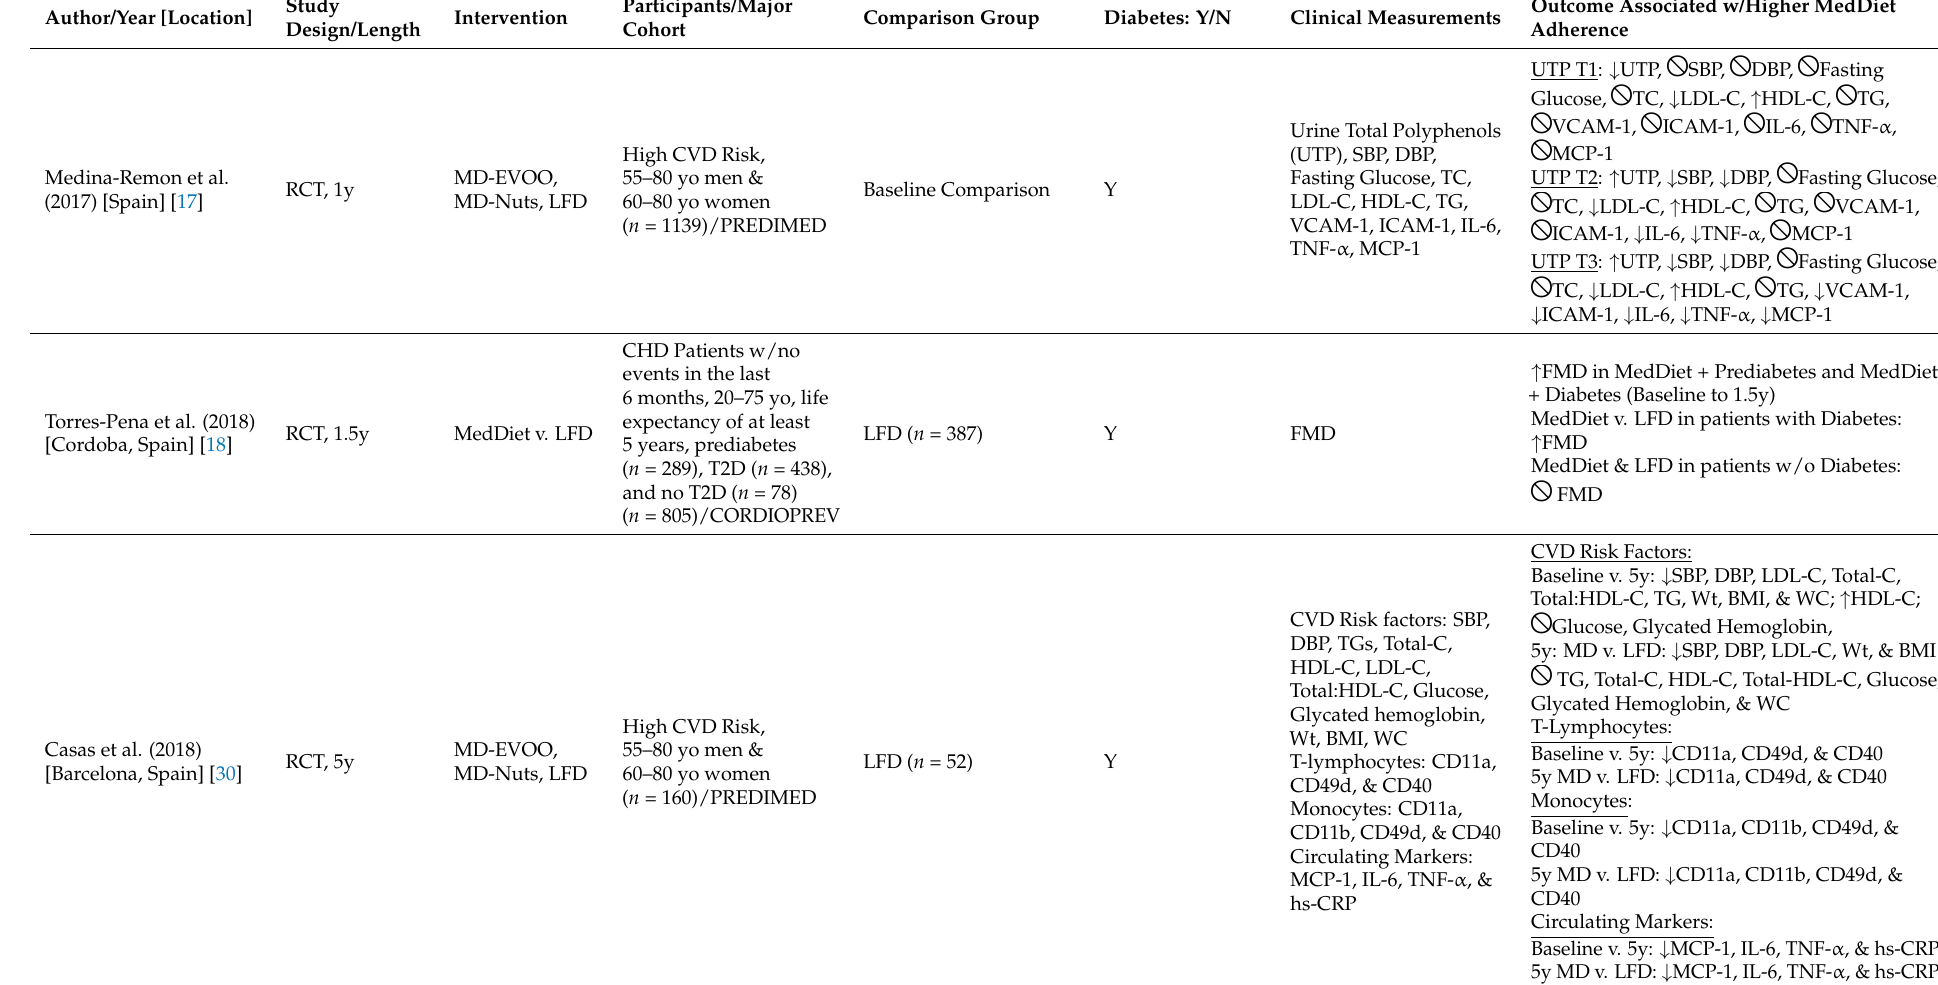
Table 2. Clinical Studies.